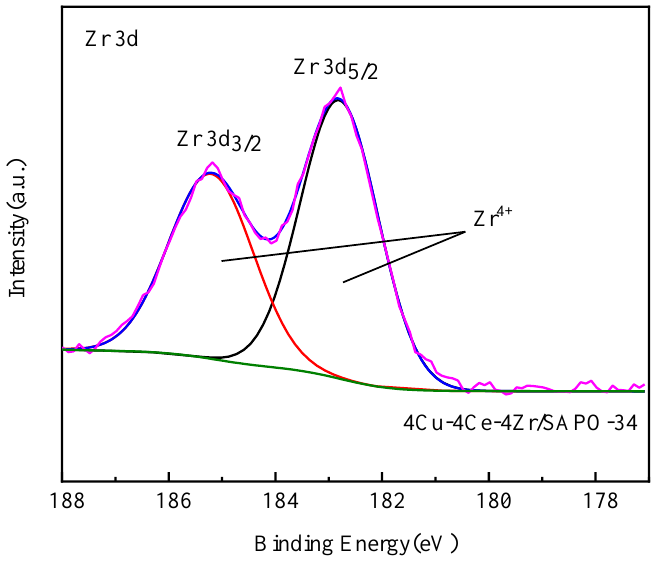
Figure 12. Zr 3d XPS spectrum of